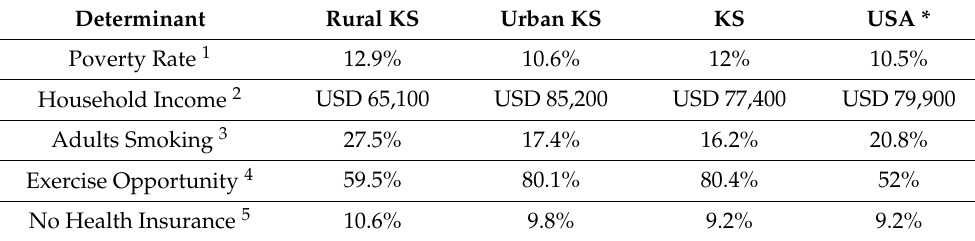
Table 1. Selected Social Determinants of Health in Rural and Urban Kansas. Determinant Rural KS Urban KS KS USA * Poverty Rate 1 12.9% 10.6% 12% 10.5% Household Income 2 USD 65,100 USD 85,200 USD 77,400 USD 79,900 Adults Smoking 3 27.5% 17.4% Exercise Opportunity